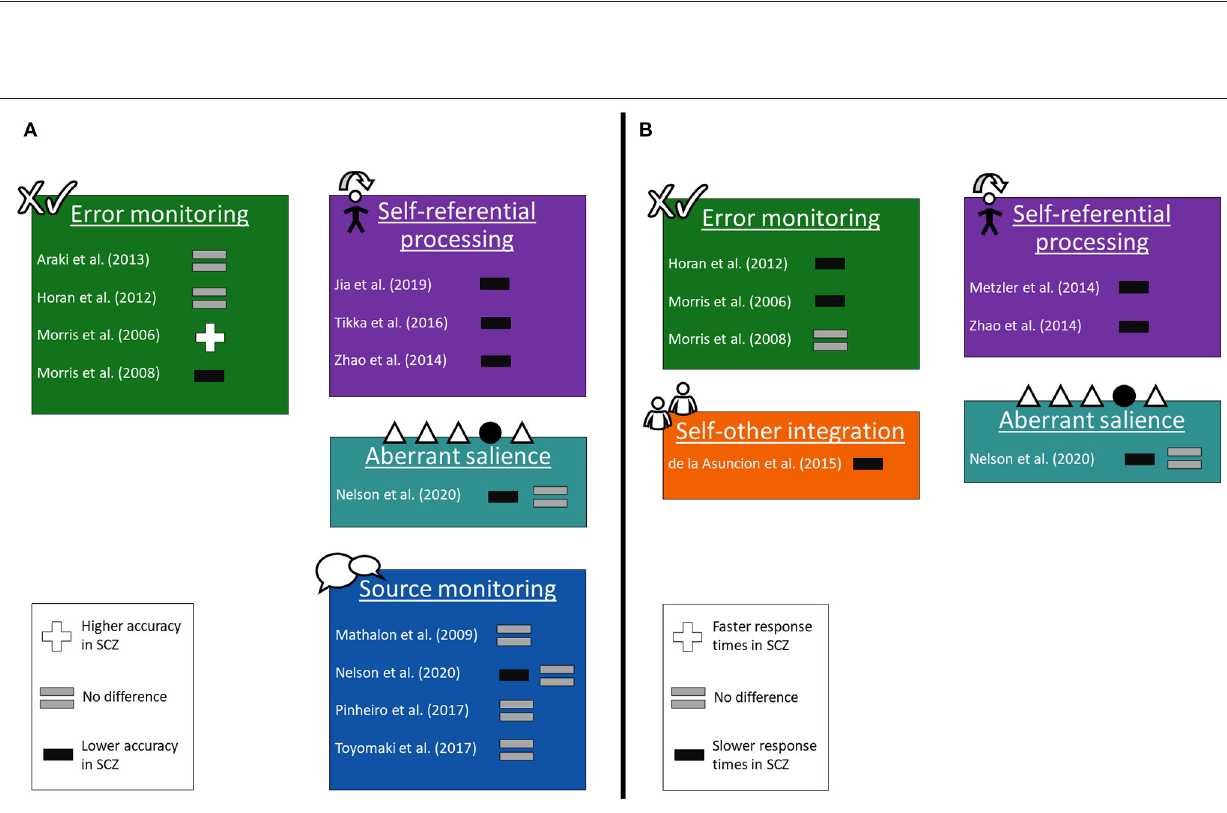
Frontiers in Psychiatry |